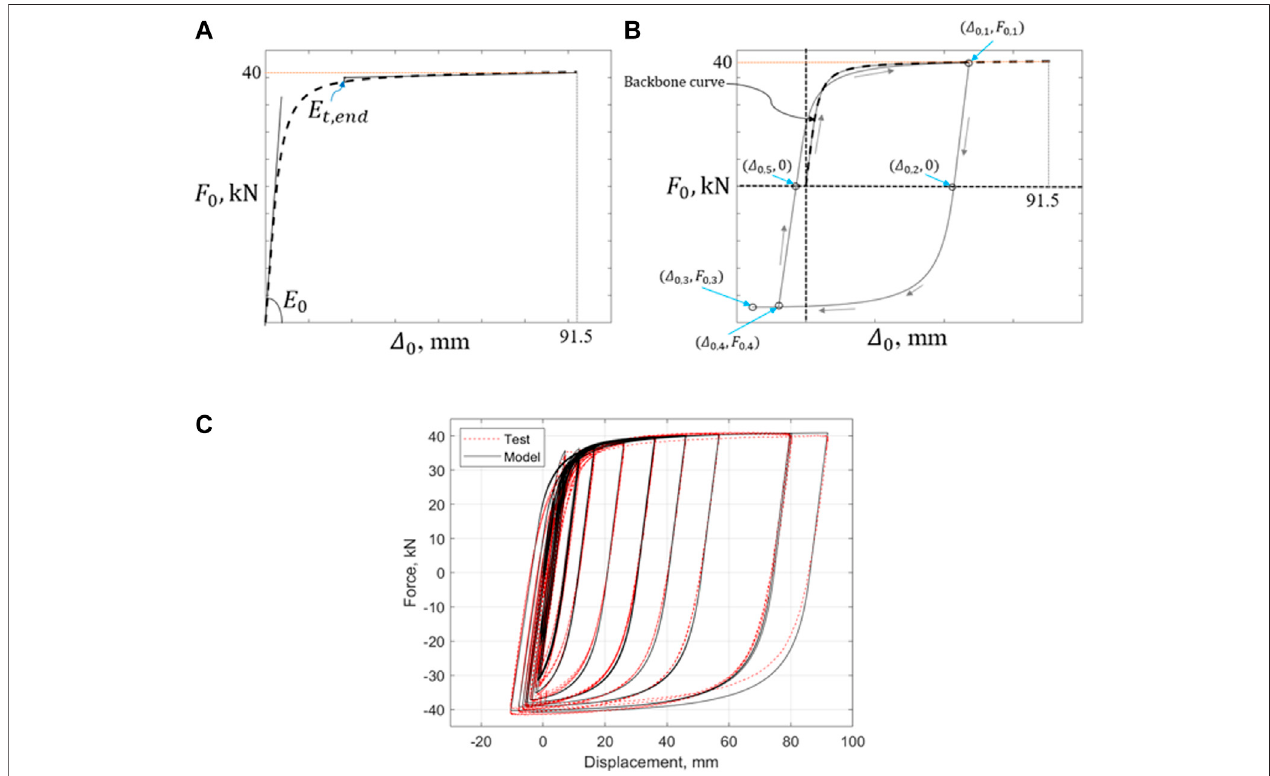
FIGURE 7 | Force-deformation curves for the O-connectors; (A) Backbone curve; (B) Hysteretic curve; (C) Comparison of hysteretic law with the test data by Nazari et al. (2015).